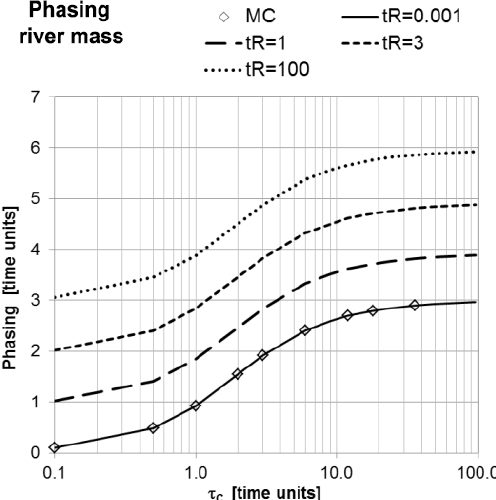
Figure 6. Phasing of total mass versus total time constant τ T = τ C + τ R